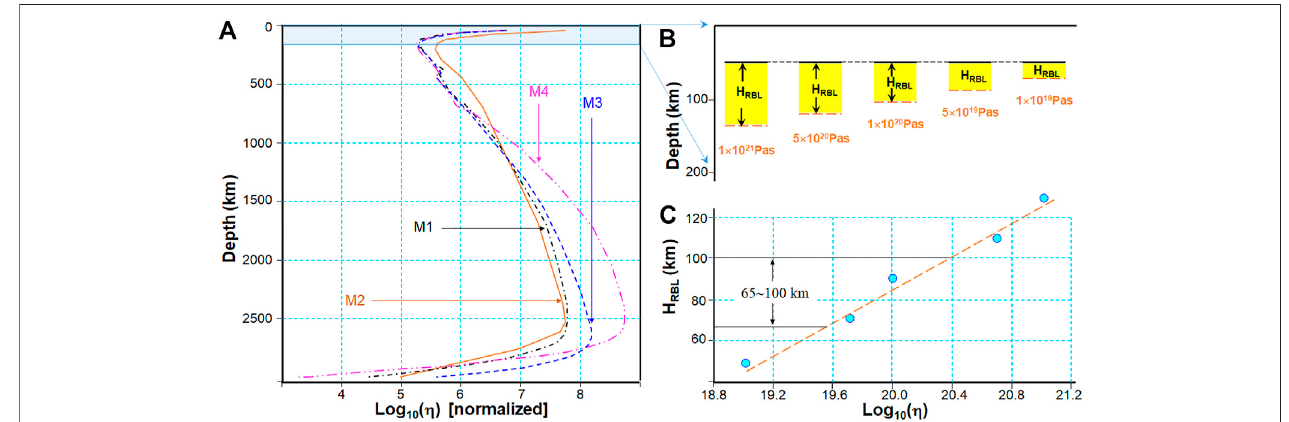
FIGURE 9 | Analysis of mantle viscosity and rheological boundary. (A) Normalized mantle viscosity model (Steinberger and Arthur 2006). (B) , (C) Changes of rheological boundary layer with mantle viscosity (He, 2014).